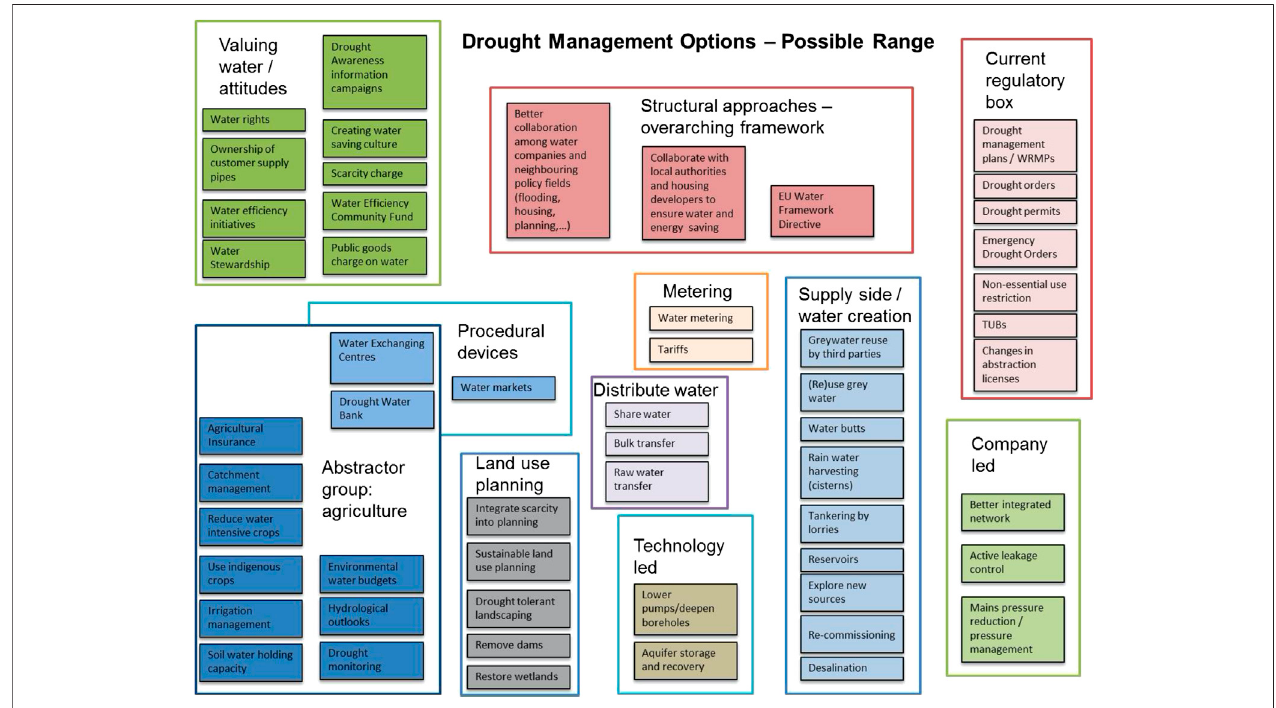
FIGURE 1 | Overview drought and water scarcity management options based on the literature and document review (adapted from Grecksch (2021))